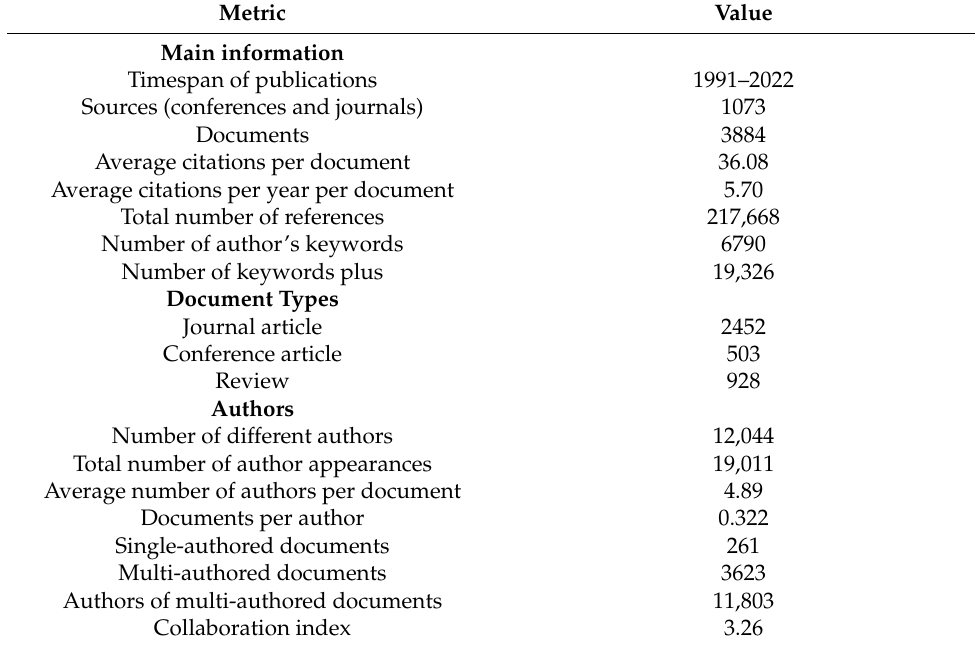
Table 1. General overview and key metrics of the identified publications.